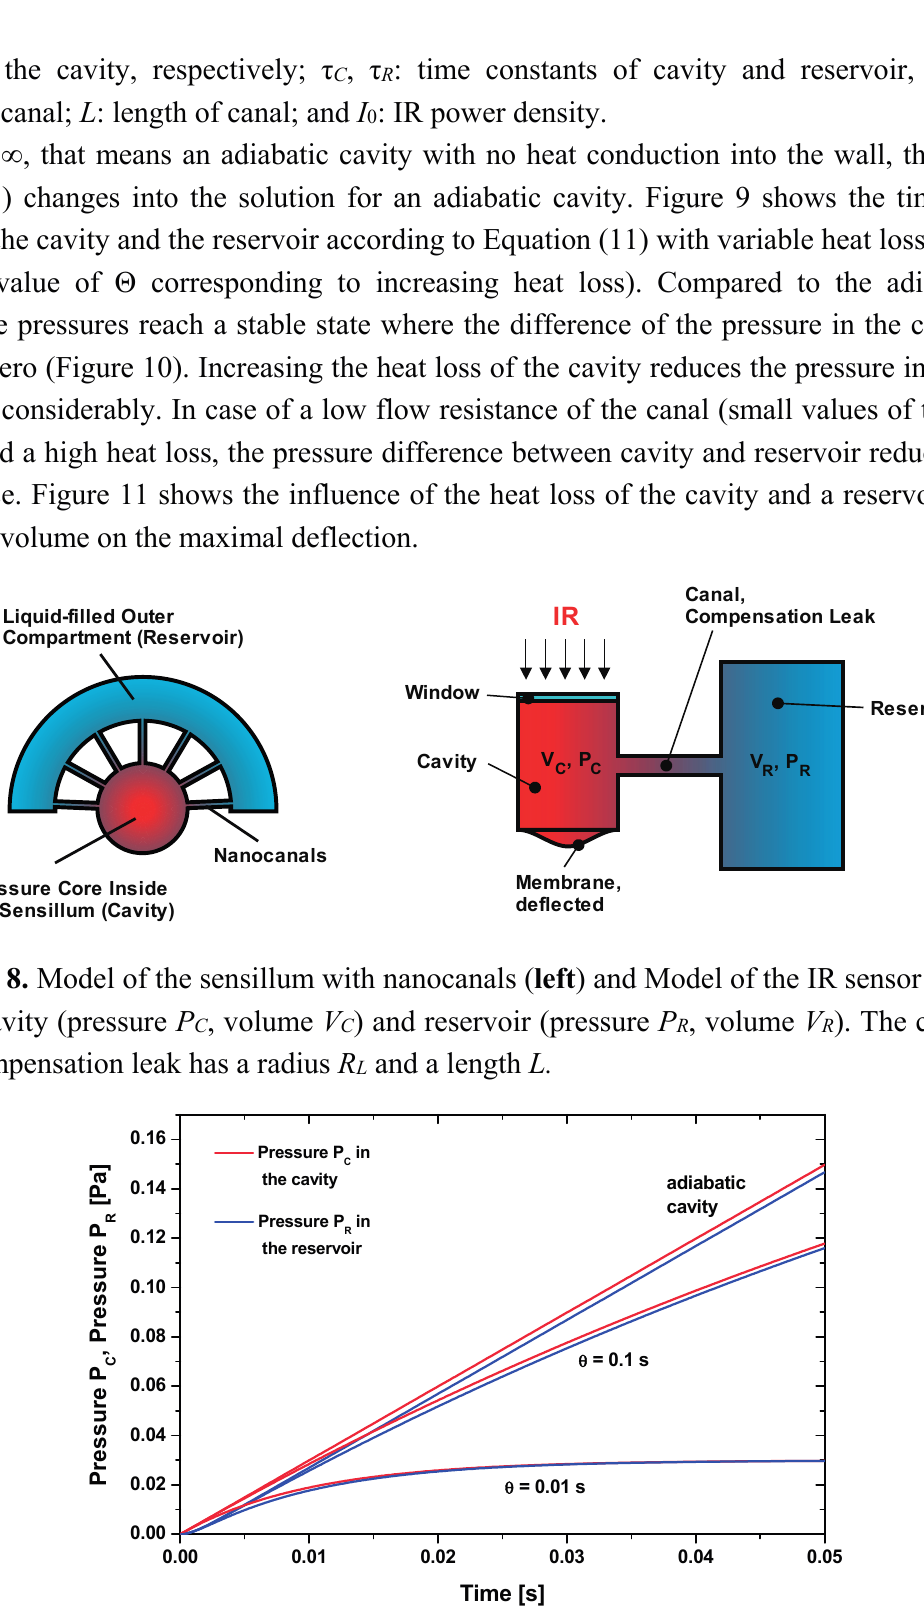
Figure 9. Time dependent pressure in the non-adiabatic cavity and the reservoir as a function of the heat loss from the cavity (decreasing value of Θ corresponding to increasing heat loss and Ω = 1000, γ = 3000 ( I o = 10 W/m 2 ), τ = 0.001 s for equal size of cavity V C and reservoir V R